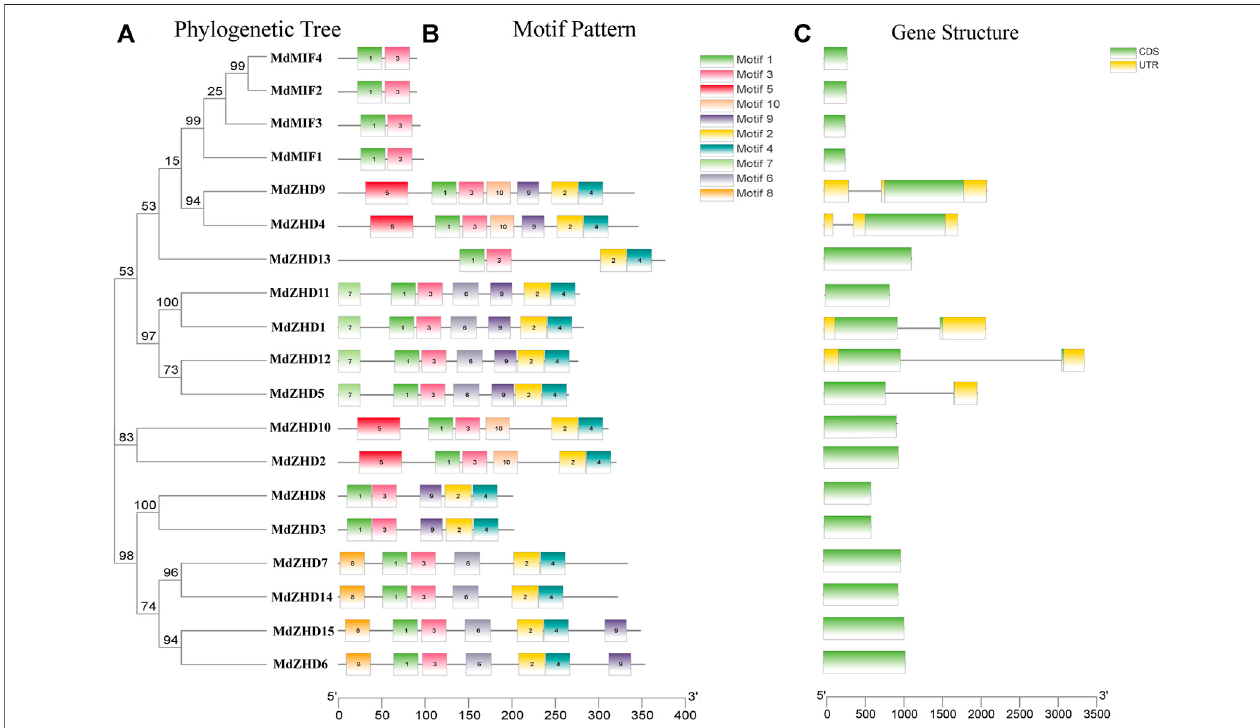
FIGURE 2 | Phylogenetic relationships (A) , conserved motifs (B) and gene structures (C) of MdZF-HD genes. Different colored boxes represent different kinds of motifs. CDS sequences are represented by green rounded rectangles, introns are represented by gray lines, and UTRs are represented by yellow boxes.